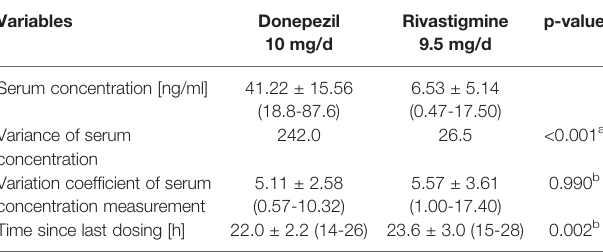
TABLE 2 | Serum concentrations of AChE-I: Daily drug dose, serum concentration, and variance of blood serum concentration for donepezil and rivastigmine group,